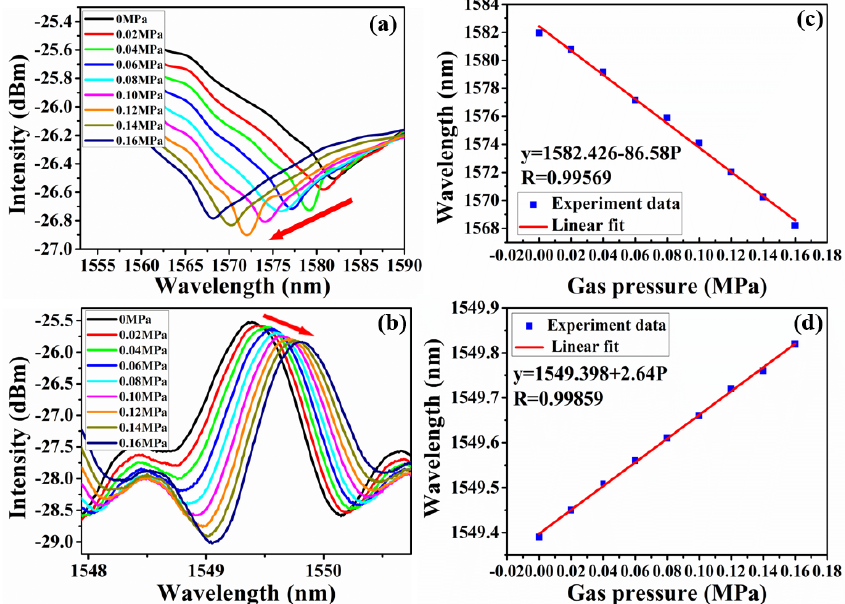
Figure 7. ( a ) The envelope curve of sensor 4 under different pressure; ( b ) partial enlarged drawing of high-frequency fringe under different pressure; ( c ) sensitivity of gas pressure measurement of sensor 4; (d) sensitivity of gas pressure measurement of high-frequency fringe.